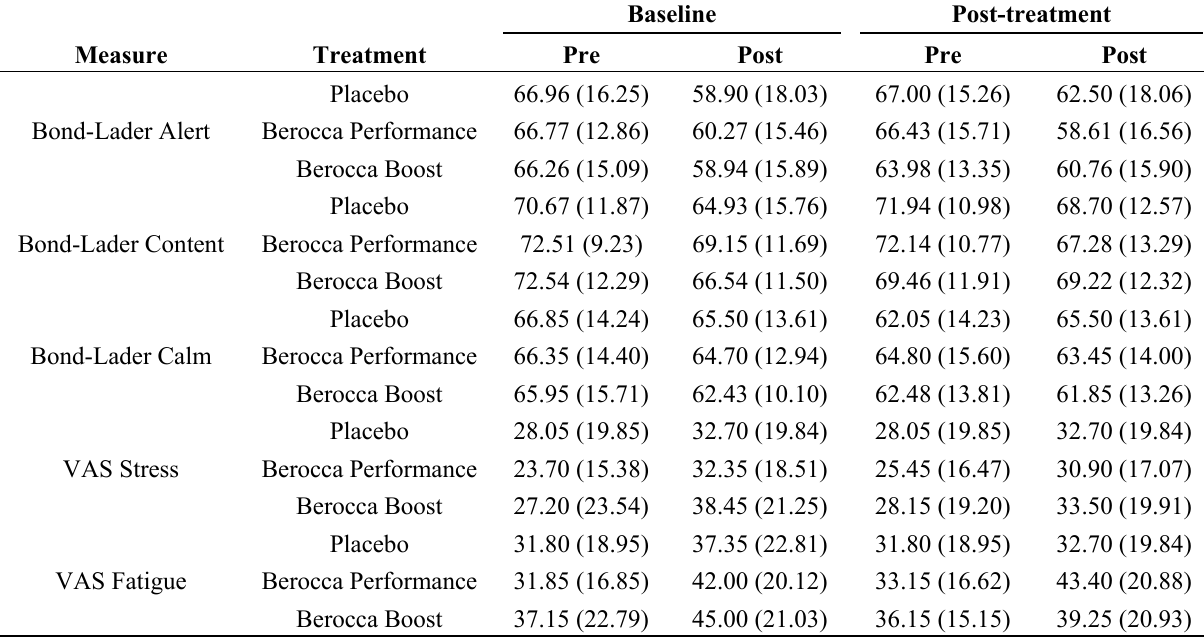
Table 2. The effects of vitamin-minerals alone (Berocca Performance) and with guaraná (Berocca Boost) on self-rated mood at baseline and post-treatment pre- and post-testing. Means with standard deviations are presented for the three Bond-Lader derived scores and the single visual analogue “stress” and “mental fatigue”